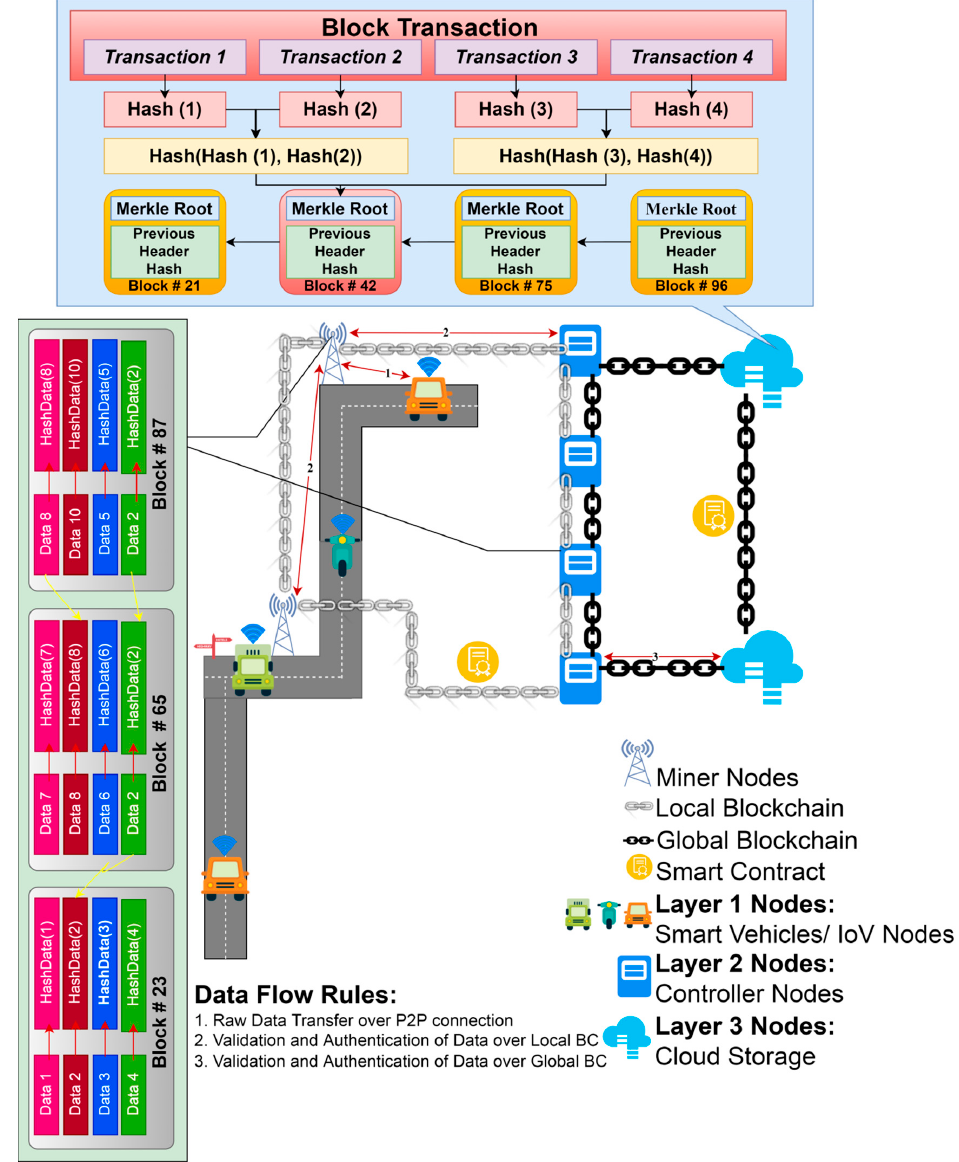
Figure 2. Relational Structure among Network